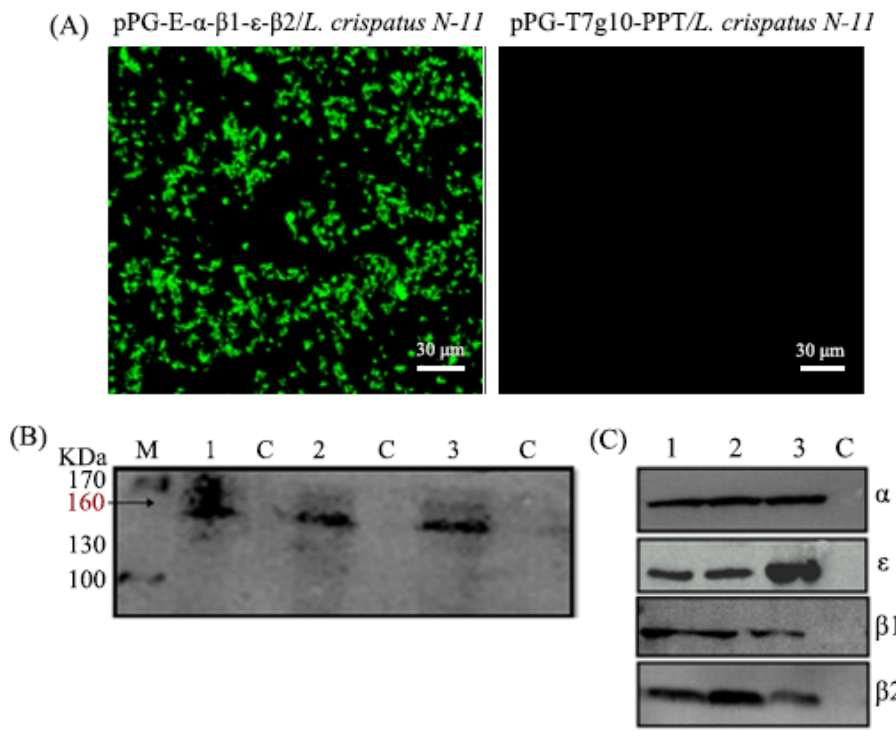
Figure 1. The constitutive expression of the toxoid proteins was evaluated using an ultra-high resolution microscope and western blotting. ( A ) The determination of the cell surface expression of α - β 1- ε - β 2 using laser confocal microscopy. Results show clear green fluorescence on the surface of the cells of pPG-E- α - β 1- ε - β 2/ L. crispatus N-11, but not on the pPG-T7g10-PPT/ L. crispatus N-11 strain. Western blotting with anti- α toxin polyclonal antibody, showing a band of expected size around 160 kDa ( B ) or mouse anti- α / β 2/ ε / β 1 toxins monoclonal antibody ( C ). M: Pre-stained protein Marker; 1-2-3: pPG-E- α - β 1- ε - β 2/ L. crispatus N-11; C: empty vector.